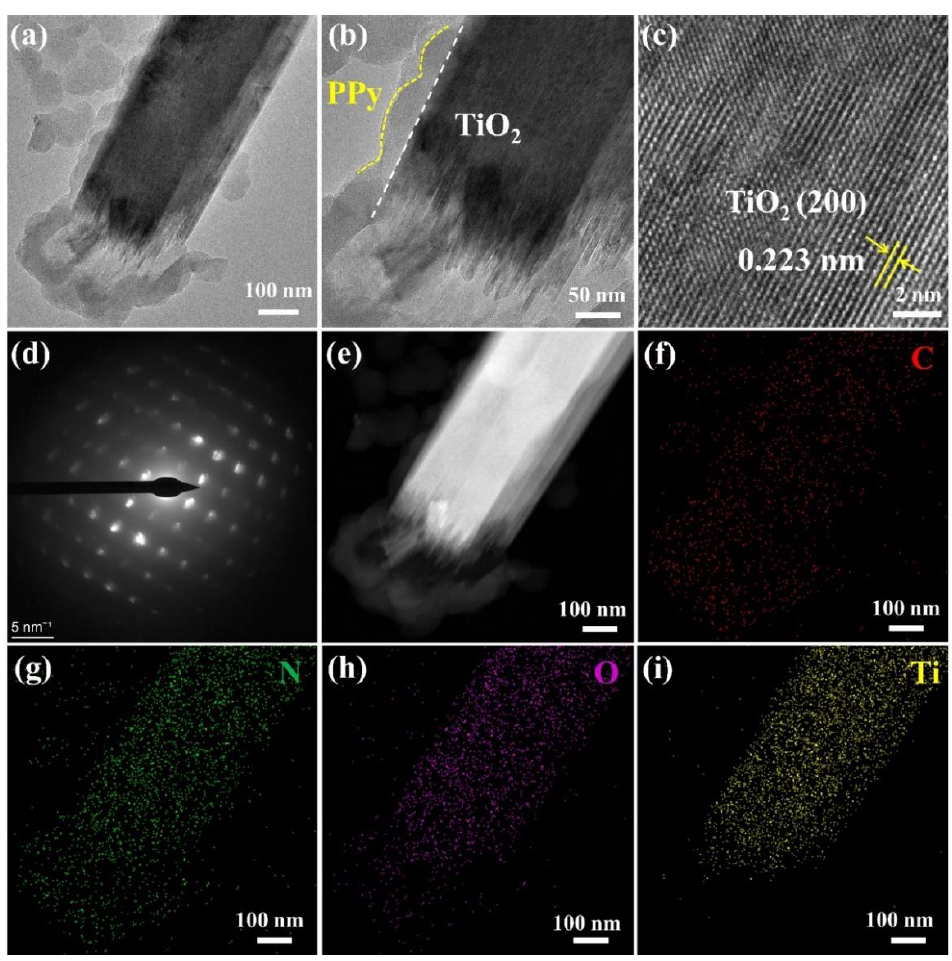
Figure 3. TEM images ( a , b ), HRTEM image ( c ), and the corresponding selected area electron diffraction pattern ( d ), STEM image ( e ), and the corresponding elemental mapping images ( f – i ) of 3PPy-TiO 2 .